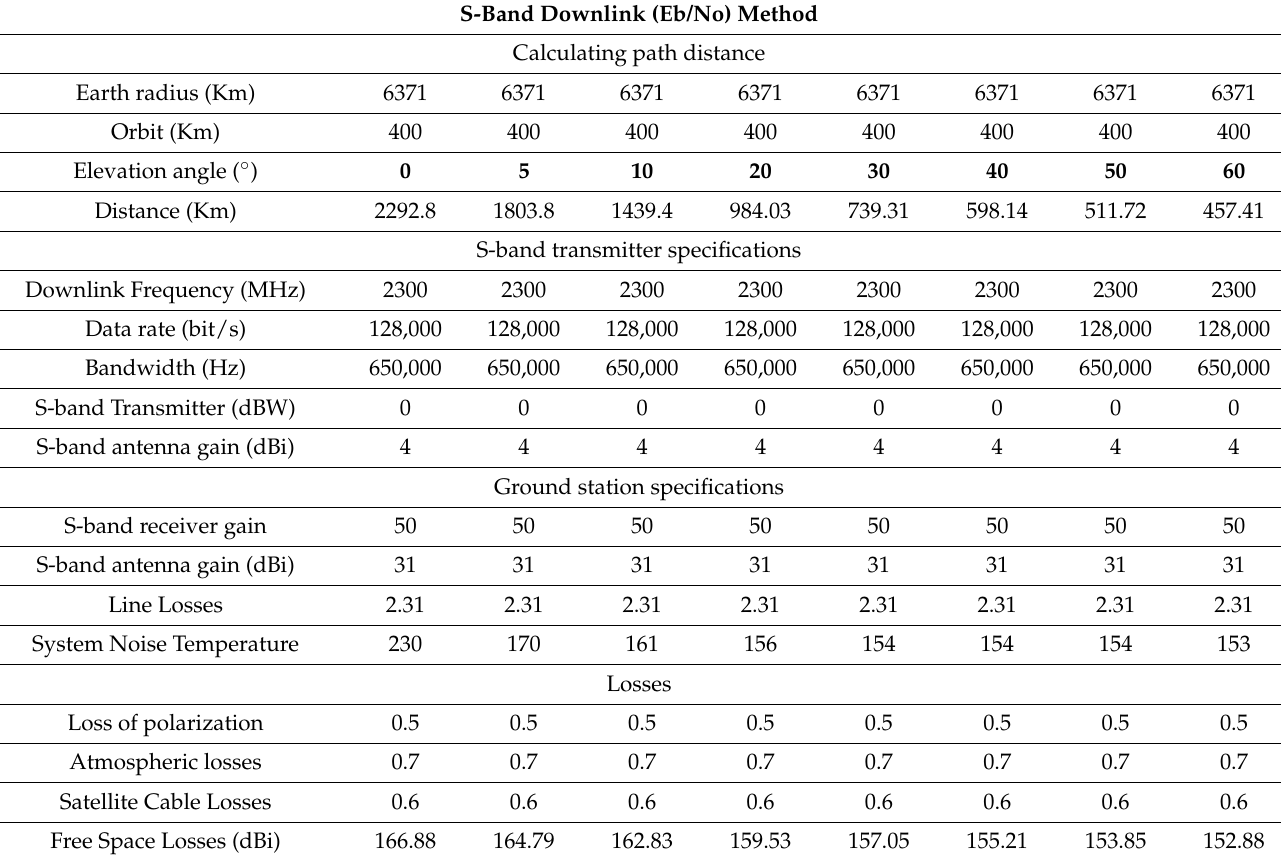
Table 7. Light-1 S − band link budget at the Vilnius ground